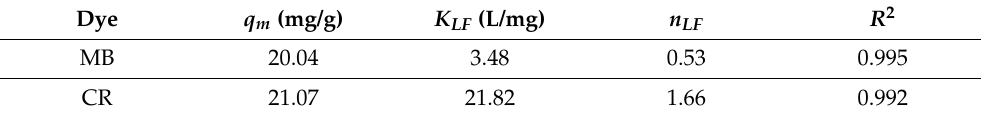
Table 4. Comparison of the adsorption capacity of the Fe 3 O 4 @C@C NPs for the anionic and cationic dyes.